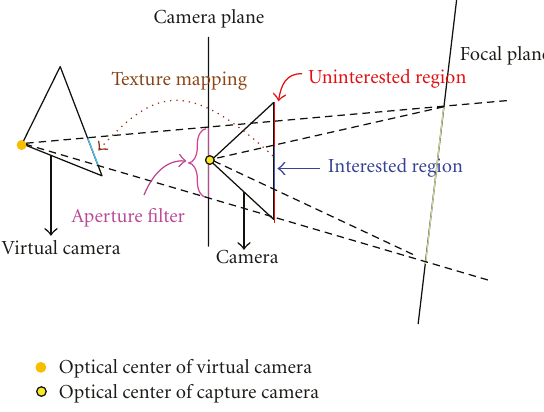
Figure 6: Region selection in rendering procedure.